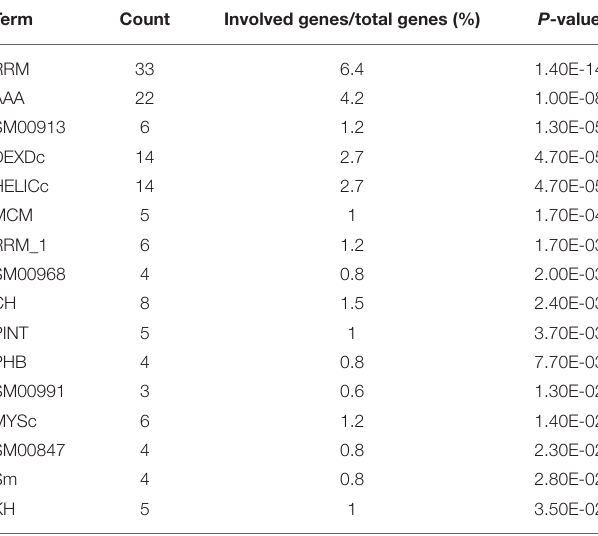
TABLE 3 | Enriched protein domains among host proteins interacting with H5N1